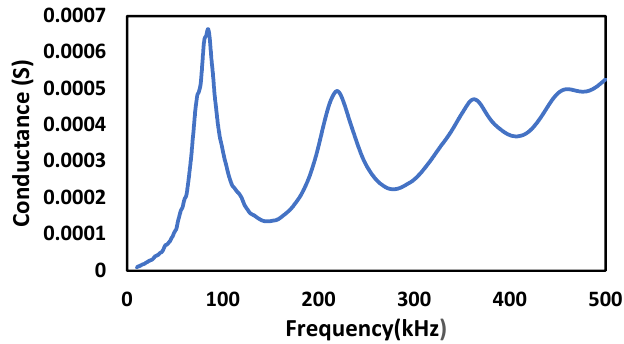
Figure 9. Schematic diagram concrete cube with embedded SSU. Table 4. Properties of the steel plate [38]. Parameters